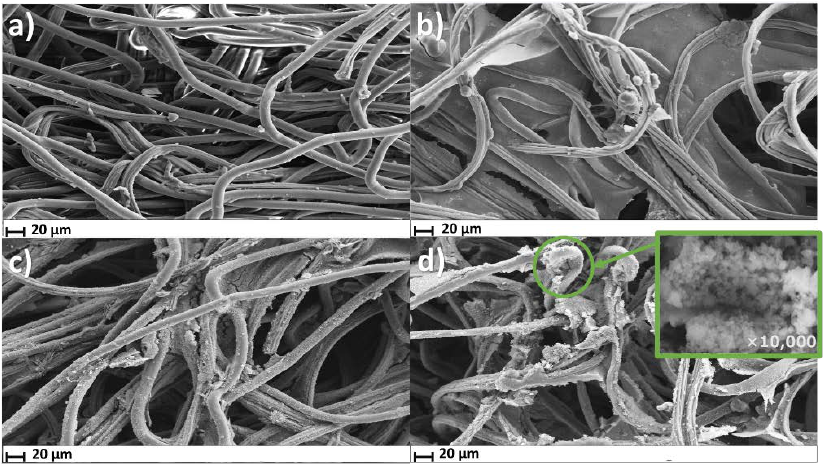
Figure 3. SEM images of ( a ) bare cotton textile; ( b ) CNT/CNC@textile; ( c ) PANI@CNT/CNC@textile; and ( d ) Cortisol-imprinted MIP@PANI@CNT/CNC@textile patches.